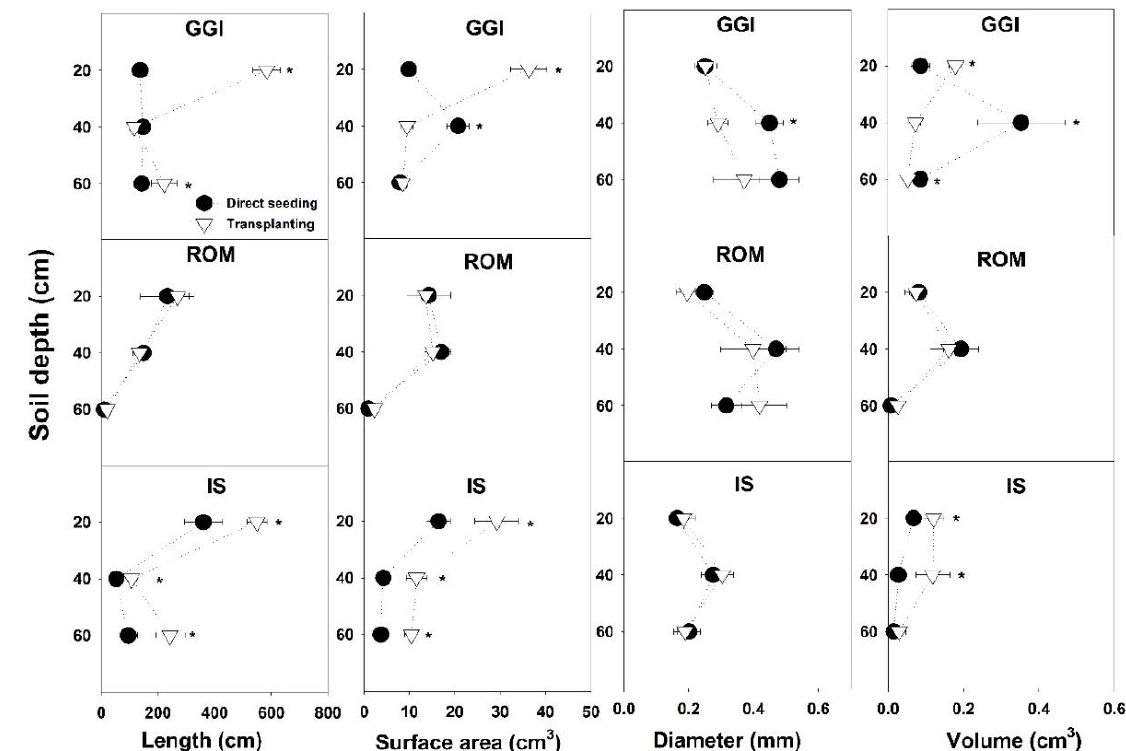
Figure 3. Root components of artichoke cultivars (Green Globe Improved (GGI), Romolo (ROM) or Imperial Star (IS)) as influenced by planting method (direct seeding and transplanting) at three soil depths during the harvesting period, July 2015. Asterisk (*) within each soil depth represents significant differences between treatments at p < 0.05.